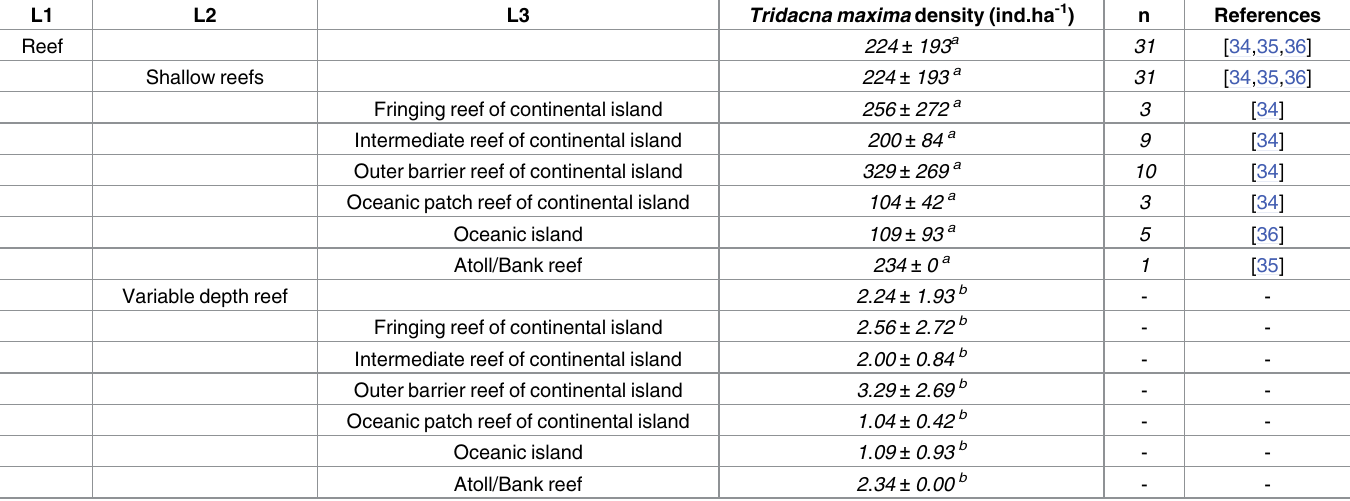
Table 3. Typologies of reef geomorphology considered in this study.